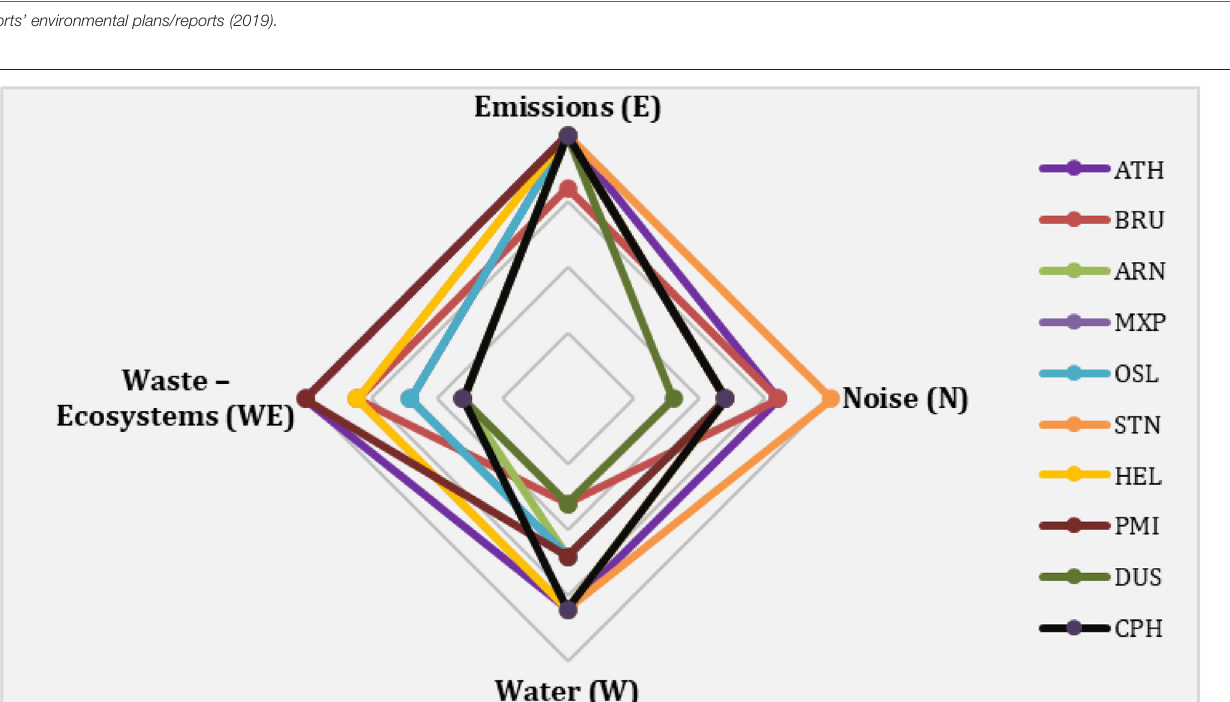
targets. Depiction of airports’ performance based on each evaluation criterion is presented in Figure 3